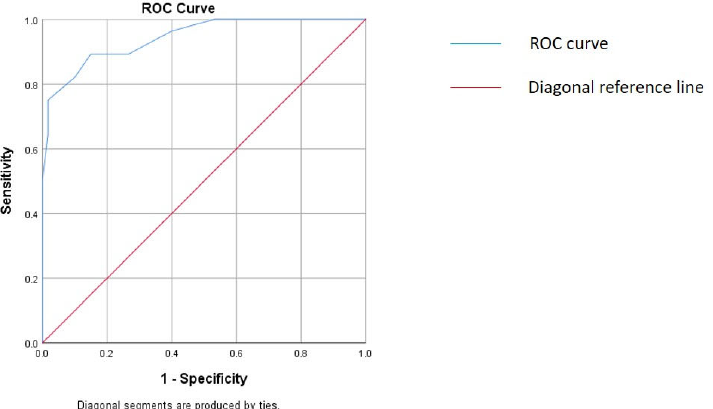
Figure 3. ROC curve analysis of the UPSA score in differentiating CIDP from other neuropathies and controls (AUC = 0.943, p <